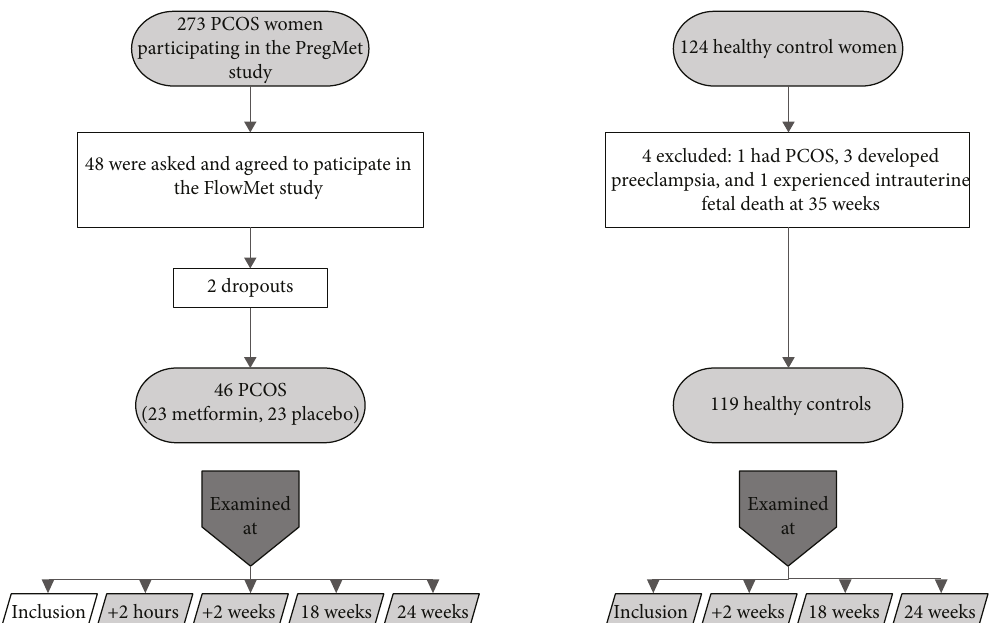
Figure 1: Participants and examinations. “ +2 hours ” is two hours after the fi rst examination, and “ +2 weeks ” is 2 weeks after the fi rst